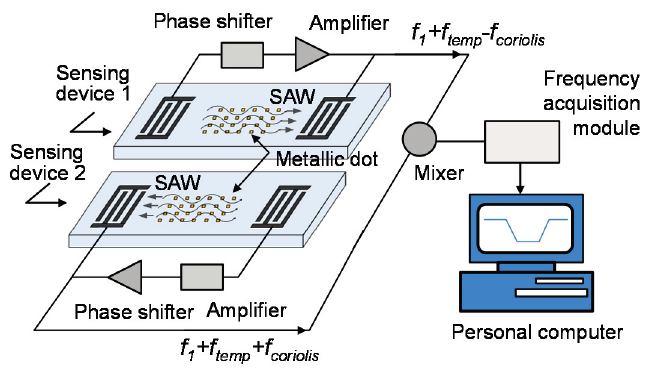
Figure 1. The scheme and working principle of the SAW micro rate